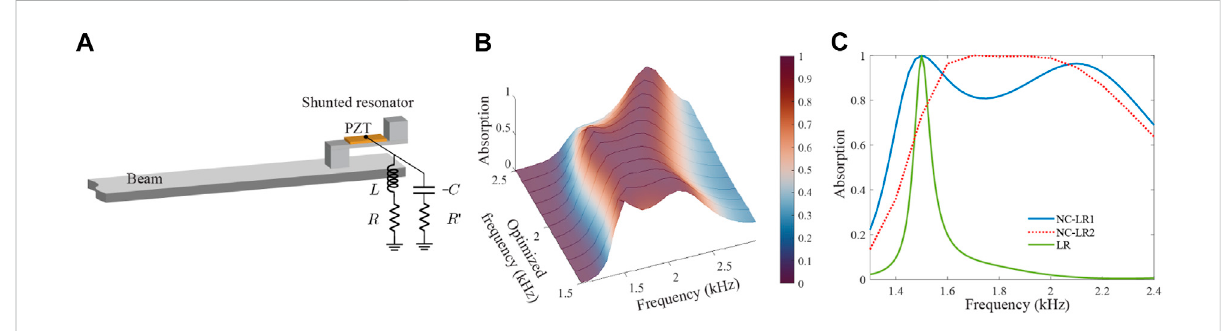
FIGURE 5 Enhanced fl exural wave absorption with a hybrid shunting circuit. (A) Schematic of the enhanced fl exural wave absorption with an NC-LR shuntedcircuit. (B) Colormapoftheabsorptionspectraoptimizedfrom1.5kHzto2.5 kHz. (C) ComparisonoftheabsorptionspectrawiththeNC-LR shunted circuit to the LR shunted